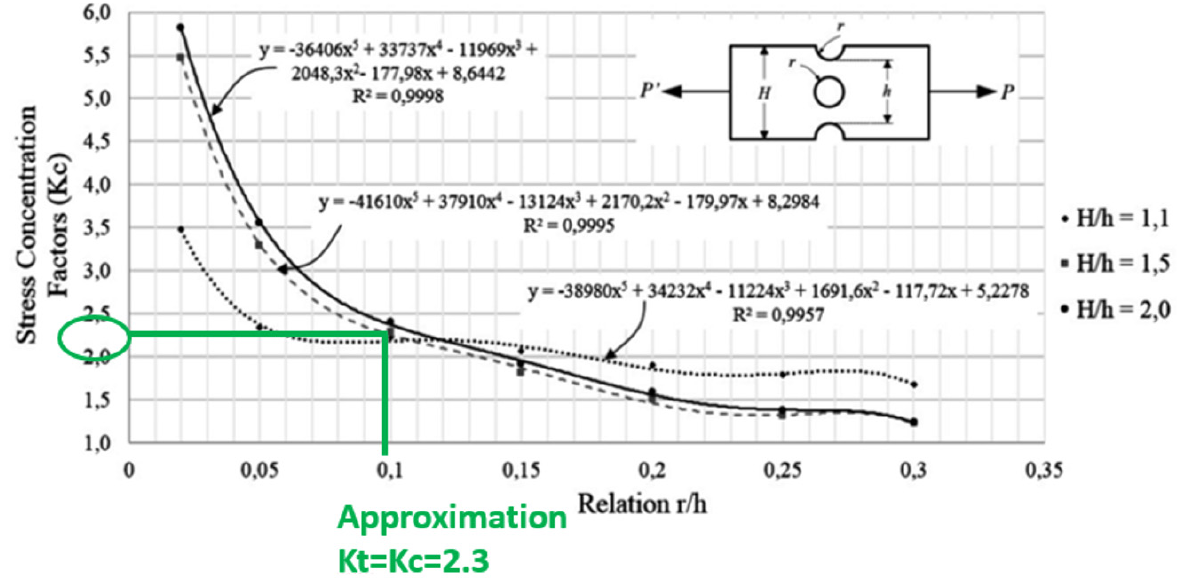
Figure 20. Stress concentration factor for notch Aluminum specimen [25].